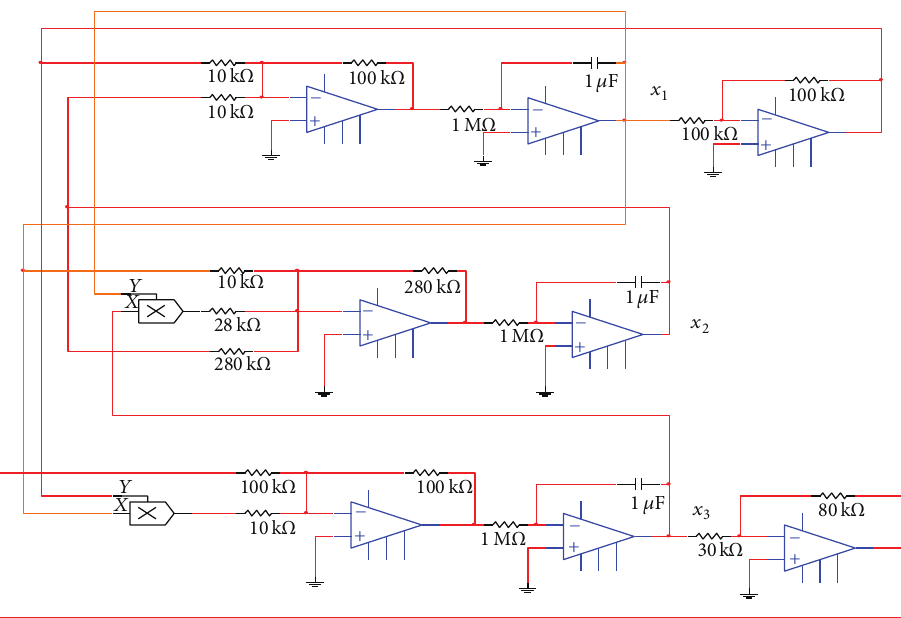
Figure 4: The electronic circuit of chaotic time-reversed Lorenz